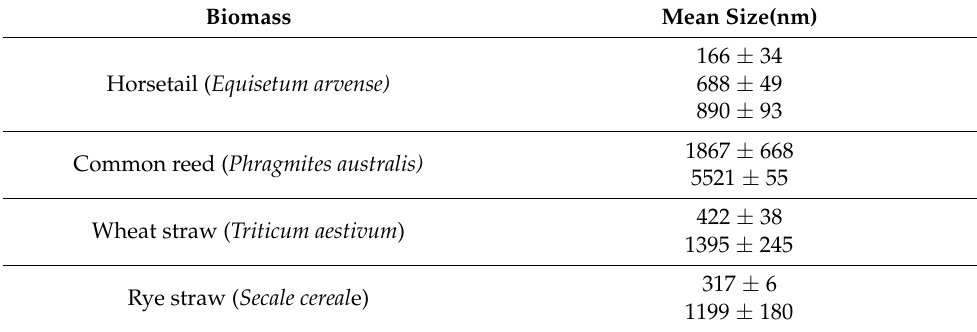
Table 1. Average size of silica powder particles derived from different types of waste biomass. Biomass Horsetail ( Equisetum arvense)